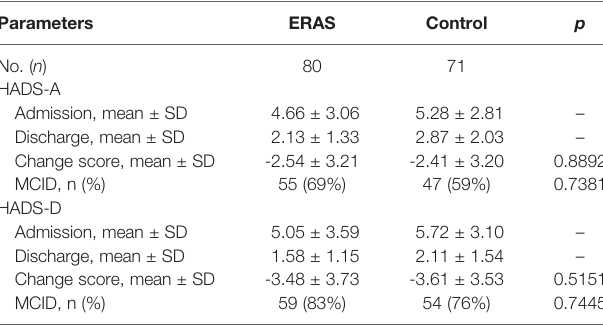
TABLE 6 | Analysis of Hospital Anxiety and Depression Scale (HADS).